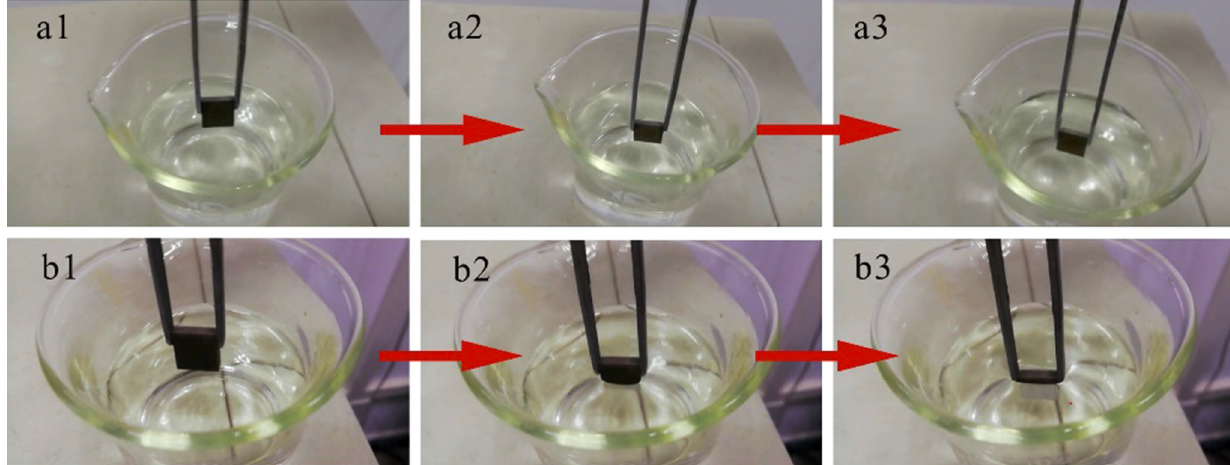
Figure 11. The state of hydrophilic and superhydrophobic samples when immersed in water. ( a ) Hydrophilic sample; ( b ) superhydrophobic sample.